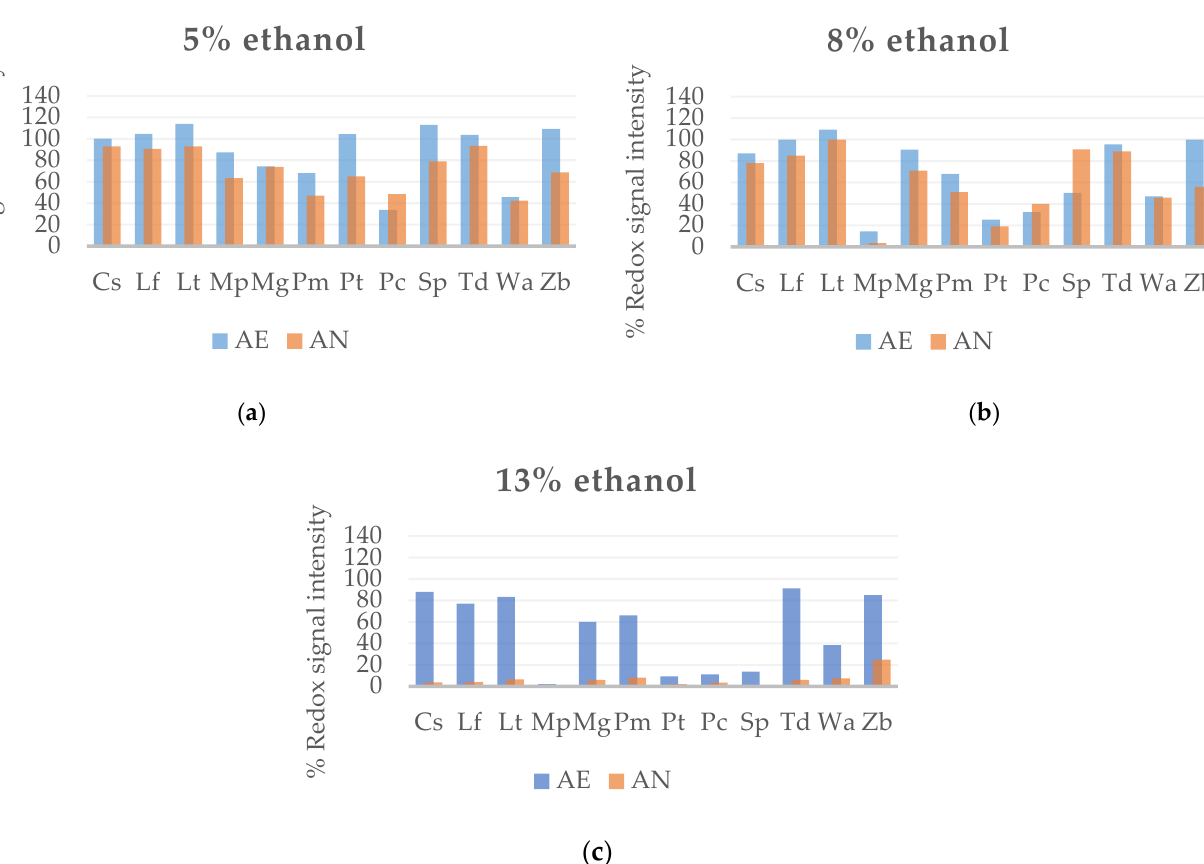
Figure 2. Metabolic output as redox signal intensity of non- Saccharomyces yeast strains under different concentrations of ethanol in AE and AN: ( a ) 5% of ethanol; ( b ) 8% of ethanol; and ( c ) 13% of ethanol.